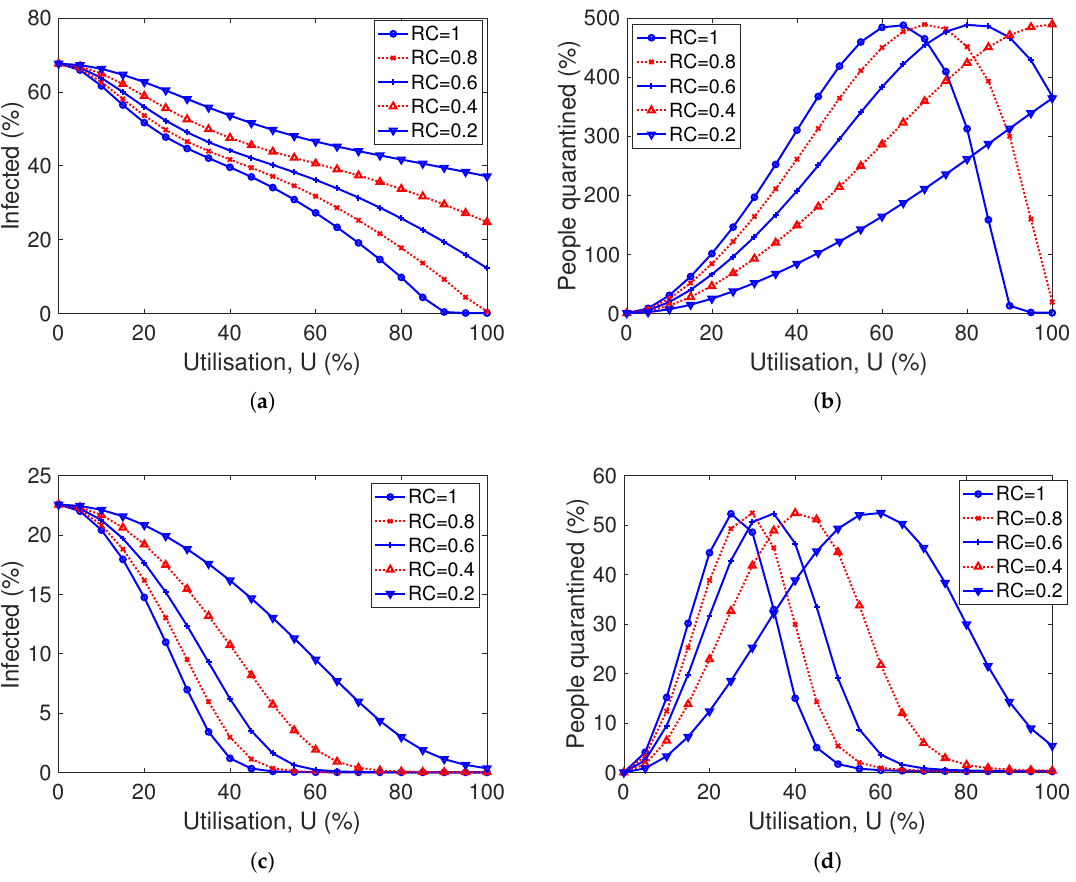
Figure 4. Efficiency of the contact tracing application depending on utilization: ( a , b ) percentage of population infected and quarantined for R 0 = 3; ( c , d ) percentage of population infected and quarantined considering other measures (for R 0 = 2); ( d ) proportion of population quarantined considering also other measures ( R ( 0 ) =